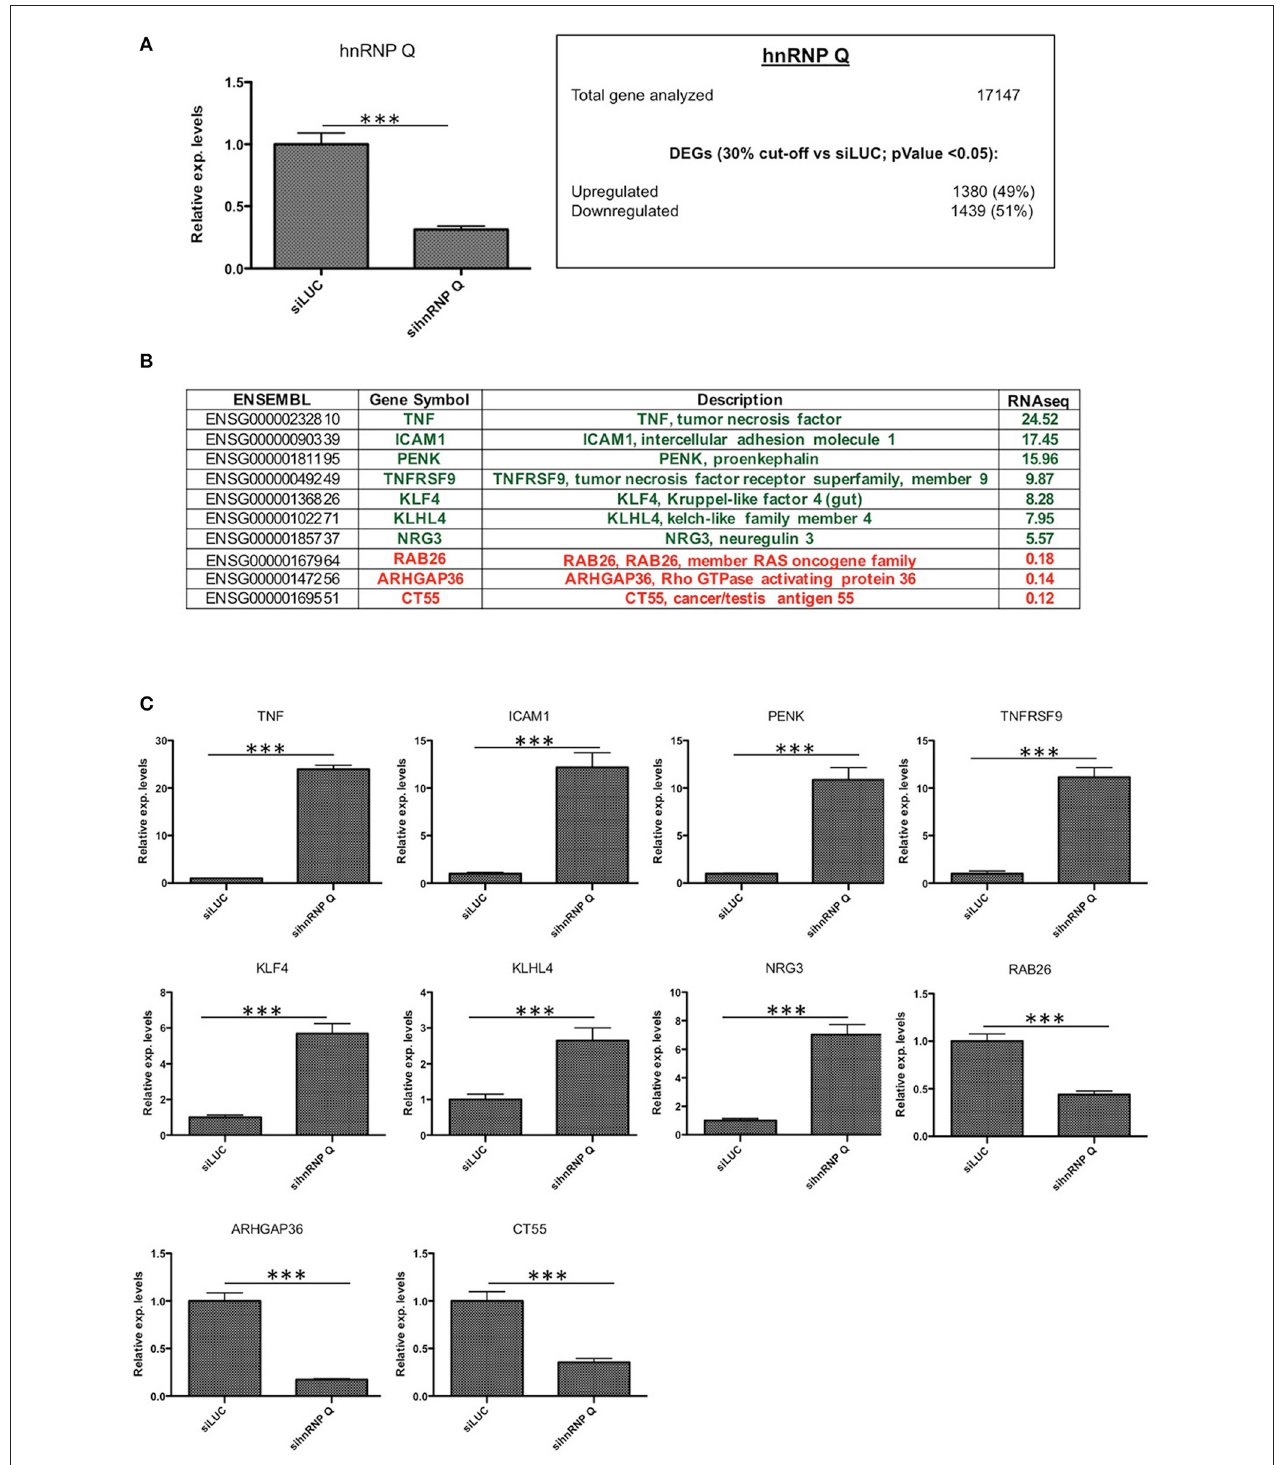
FIGURE 3 | Validation of hnRNP Q silencing and comparison between RNA-seq and RT-qPCR results. (A) Assessment of hnRNP Q siRNA silencing efficiency using qPCR (*** p < 0.001) and summary of differentially expressed genes (DEGs with p < 0.05) with number of downregulated ( < 0.7x vs. siLUC) and upregulated ( > 1.3x vs. siLUC) genes after sihnRNP Q treatment. (B) List of DEGs validated by RT-qPCR and associated with brain functions/neurodegeneration (PENK KLF4, KLHL4, NRG3, RAB26, and ARHGAP36), inflammation (TNF, ICAM1, TNFRSF9), and other functions (CT55). (C) RT-qPCR validation of 10 selected transcripts. Each bar reports mean ± standard error of three independent experiments. Statistical differences were evaluated using t-students (* p < 0.05, ** p < 0.01, *** p < 0.001).